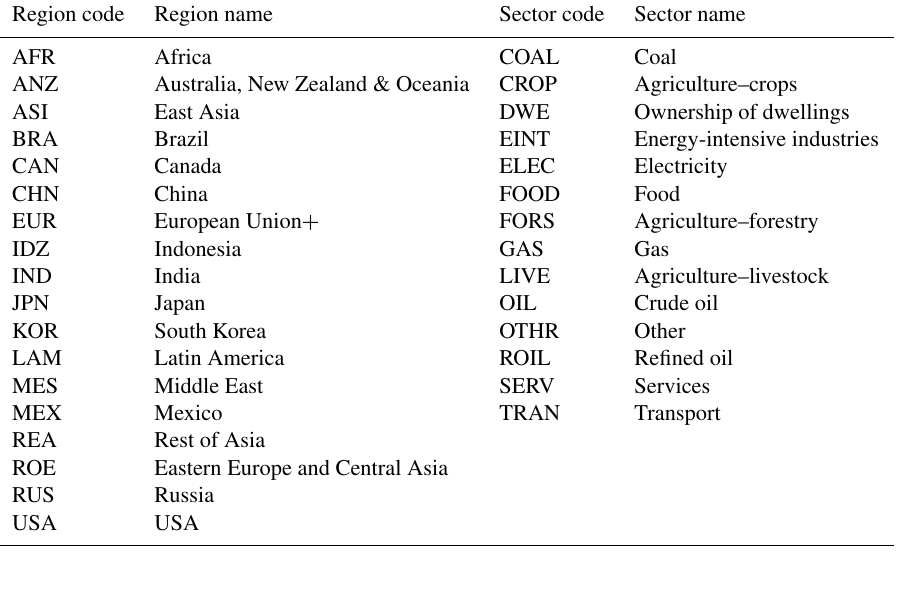
Table B1. EPPA7 regions and sectors, as described in Paltsev et al. (2021).